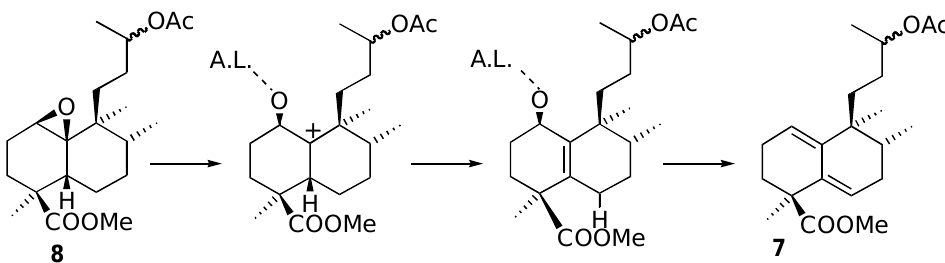
Figure 4. Proposed mechanism for the formation of 7 .